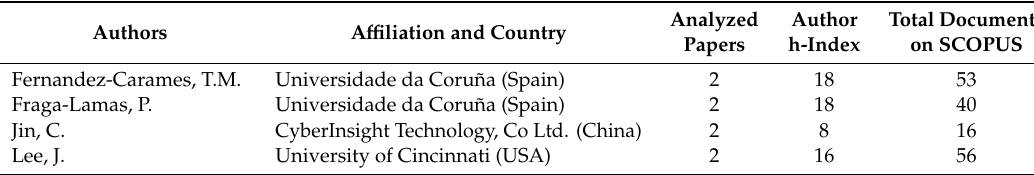
Table 2. The most productive authors (source: Scopus).